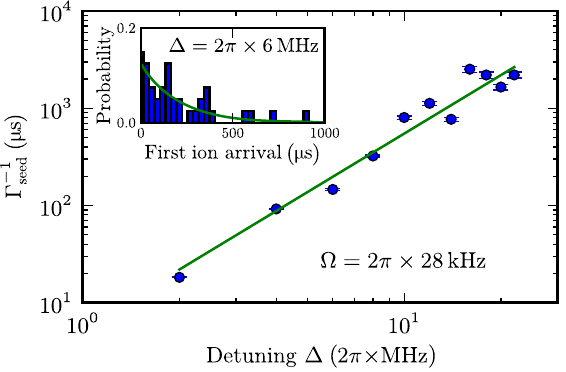
FIG. 9. We retrieve the seed rate Γ by fitting an exponential seed t Þ to the probability of detecting a first ion after decay exp ð − Γ seed the time of flight t to our ion detector (inset). From a ∼ Δ 2 fit to the extracted seed rates, we can calculate the Rabi frequency Ω , taking into account the finite detection and ionization efficiency, as well as the bare decoherence